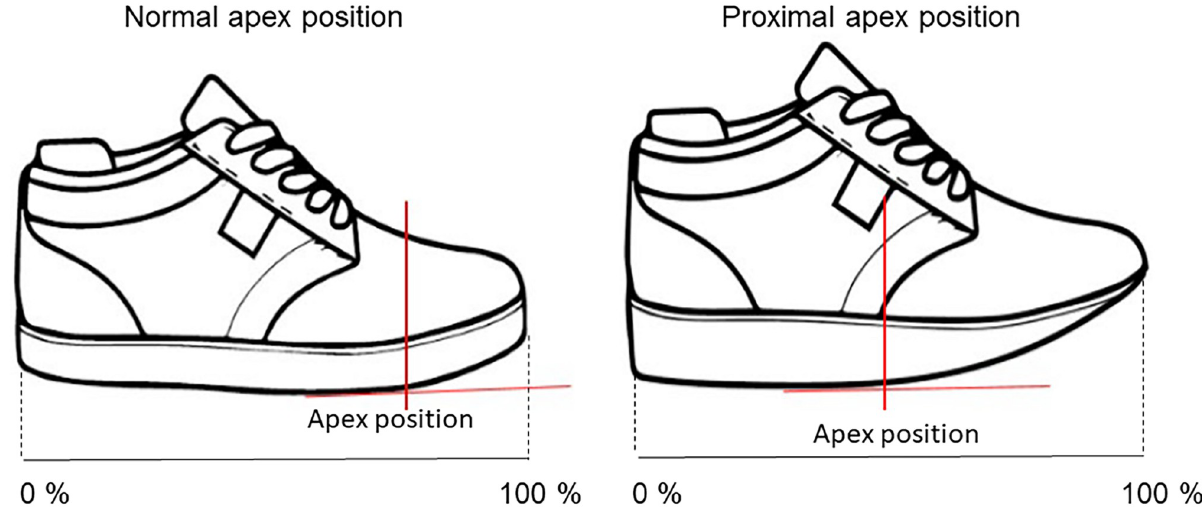
Fig 2. Illustration of a shoe with a normal and proximal apex position. Total shoe length is indicated as percentage. The proximal apex position is at ~50% of total shoe length.